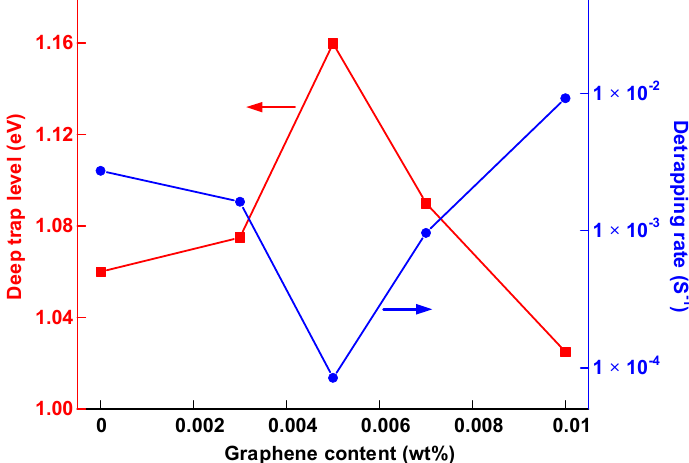
Figure 9. The deep trap level of graphene/LDPE nanocomposites as well as the de-trapping rate ( P de ) at 60 °C.